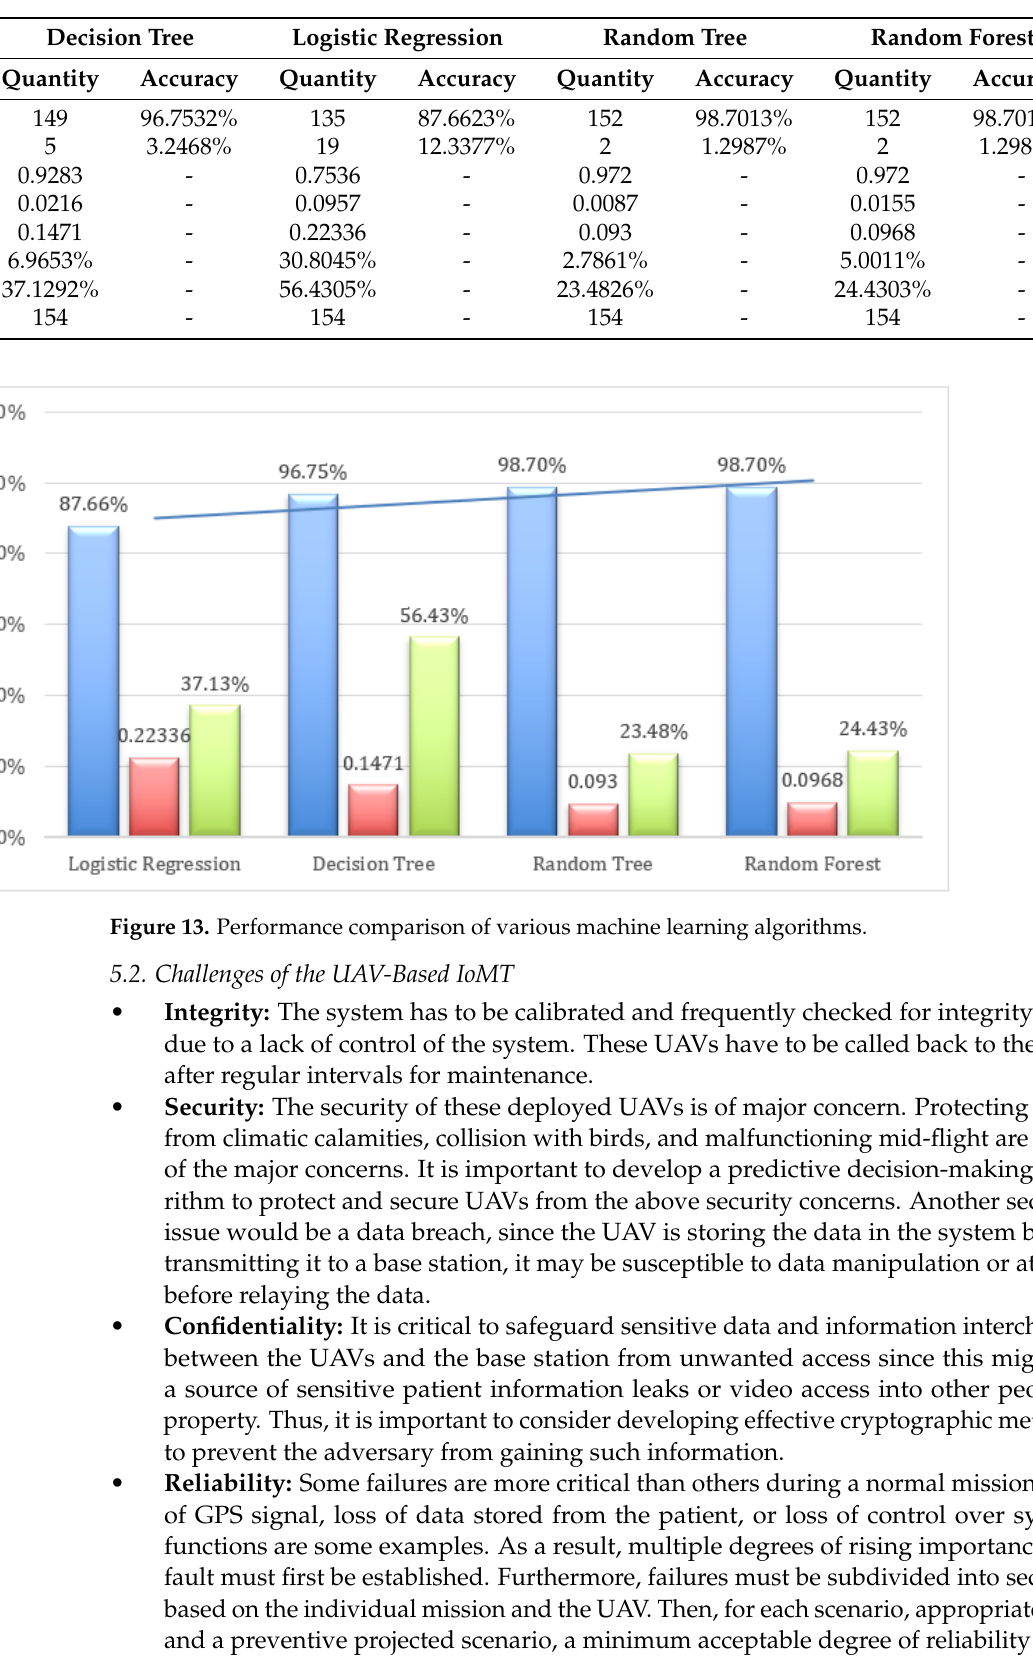
Table 3. Results of different ML algorithms.